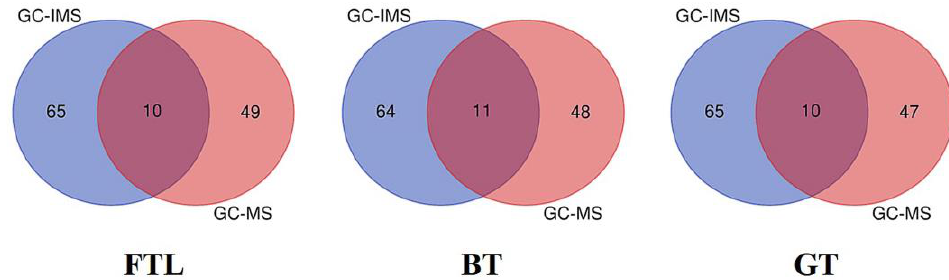
Figure 5. Venn diagram of the flavor of GC-MS and GC-IMS in different